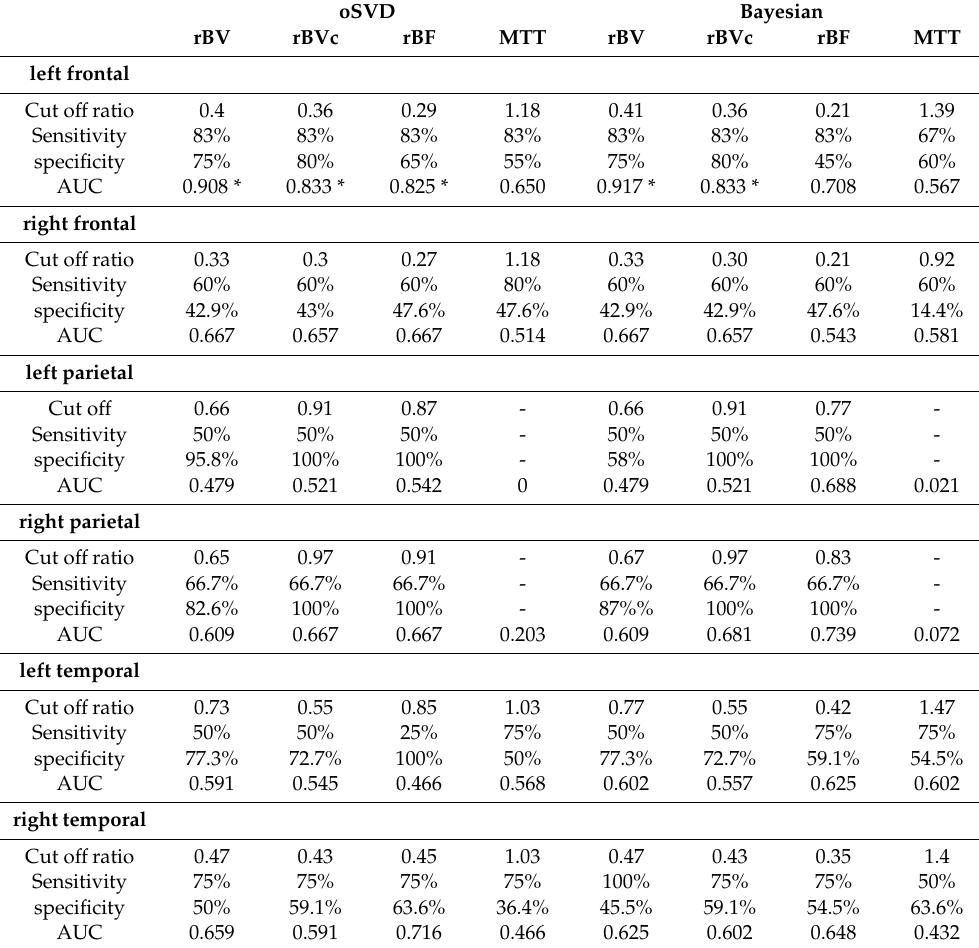
Figure 6. Optimal cut-o ff points for the ratio of cortical / white matter perfusion in the left frontal lobe for calculated hemodynamic parameter maps for oSVD and BAY deconvolution. rBVc ratio cut o ff = 0.36 marked red; greater values “predict” hypoperfusion in SPECT with a sensitivity of 83% and specificity of 80%. Significant results ( p < 0.05) are marked with *. Table 4. Cut-o ff ratios of white matter / cortex perfusion values of relative cerebral blood volume (rBV), relative cerebral blood volume corrected for leakage (rBVc), relative cerebral blood flow (rBF) and mean transit time (MTT) calculated by ROC